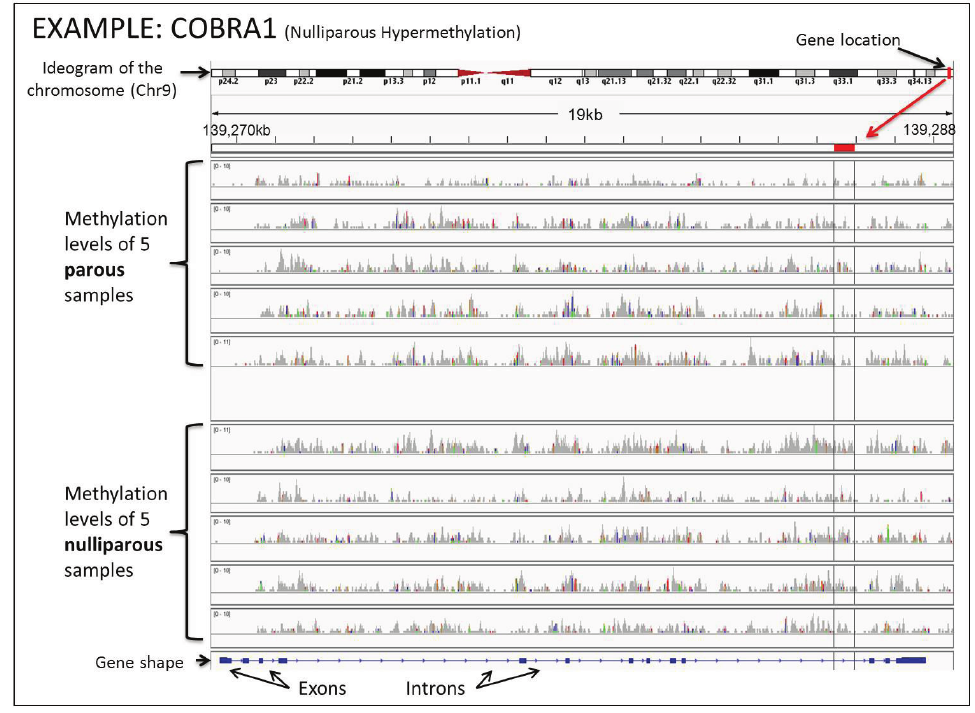
Figure 1. Overview of how the DNA methylation levels appear in the Integrative Genomics Viewer (IGV). At the top of the figure is the ideogram of the chromosome given by IGV, with the area currently being examined marked in red. At the bottom is the overall shape of the gene containing exons and introns. Exons are shown as thicker blue sections on the overall gene. The gray bars represent the methylation levels of each volunteer at each base pair. They are created by combining each read resulting from the sequencing done on the samples. The higher they are, the higher the percentage of methylation is at any given base pair. When there was an area of higher methylation occurring in at least four of the members of one parity group as compared to all members of the opposing group, that area was defined as a differentially methylated region